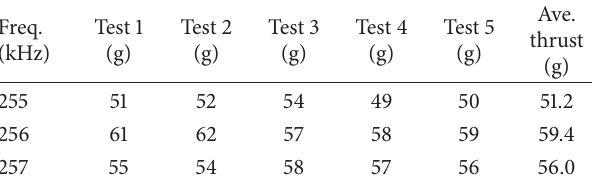
Table5:Thrustsofpiezoelectricactuatorcontainingdoublepushers (preload of 215g, drive voltage